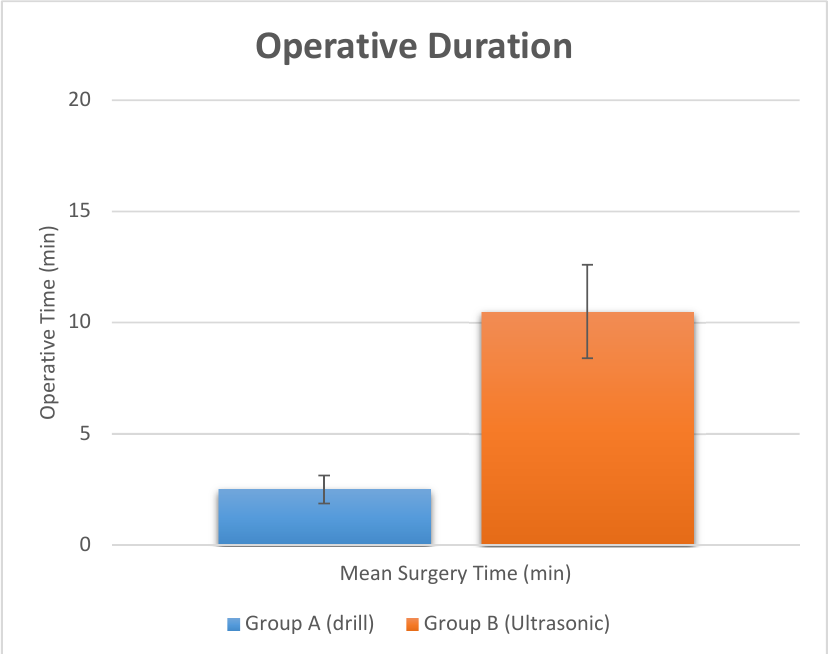
Figure 3. Operative surgery duration evaluated for the two study groups.